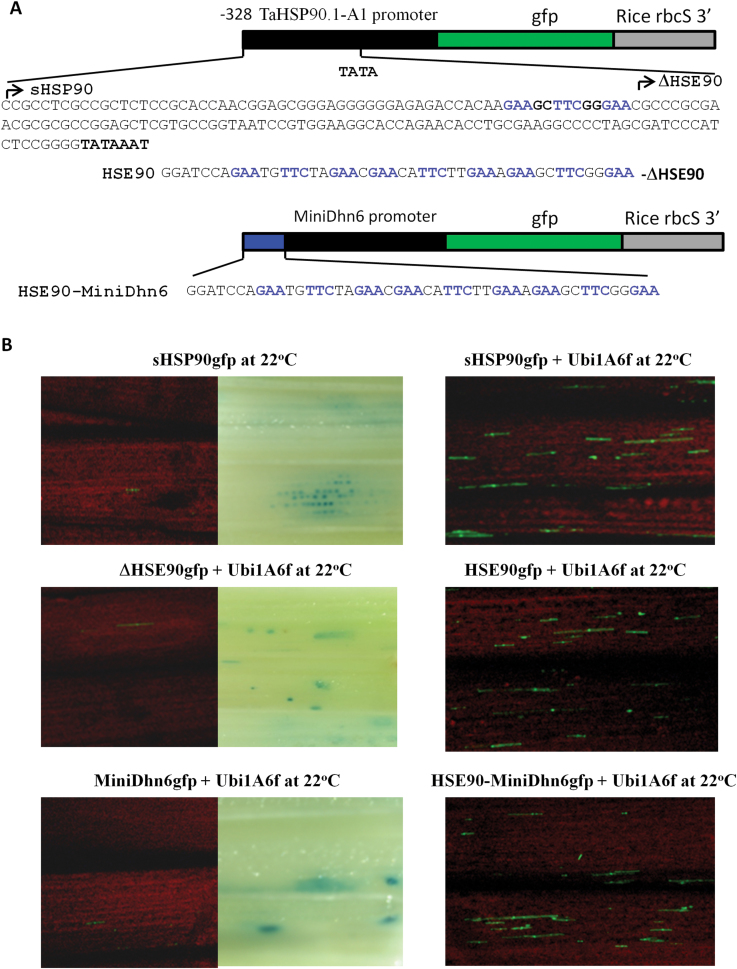
Functional analysis of the TaHSP90.1-A1 promoter and TaHSP90.1E1 HSE (GAAGCTTCGGGAA) in wheat seedlings. (A) Reporter gene constructs. A short TaHSP90.1-A1 promoter (sHSP90) has a 328-bp fragment upstream of the translational start codon, which contains TaHSP90.1E1. The sequence upstream of the TATA box of TaHSP90.1-A1 promoter is shown. The ΔHSE90 promoter starts immediately downstream of the TaHSP90.1E1 HSE. HSE90 construct contains three TaHSP90.1E1 HSE repeats, which are added immediately upstream of the ΔHSE90 promoter. The HSE90-miniDhn6 construct was made by adding three TaHSP90.1E1 HSE repeats to a minimal promoter of the drought-inducible Dhn6 gene. (B) Transactivation analysis. A GFP reporter gene was introduced into the shoots of wheat seedlings with or without the TaHsfA6f effect construct (Ubi1A6f). A Ubi1:GUS+ reporter gene was also co-introduced. Illustration of GUS foci is given only when GFP reporter expression is essentially undetectable in the tissue section.